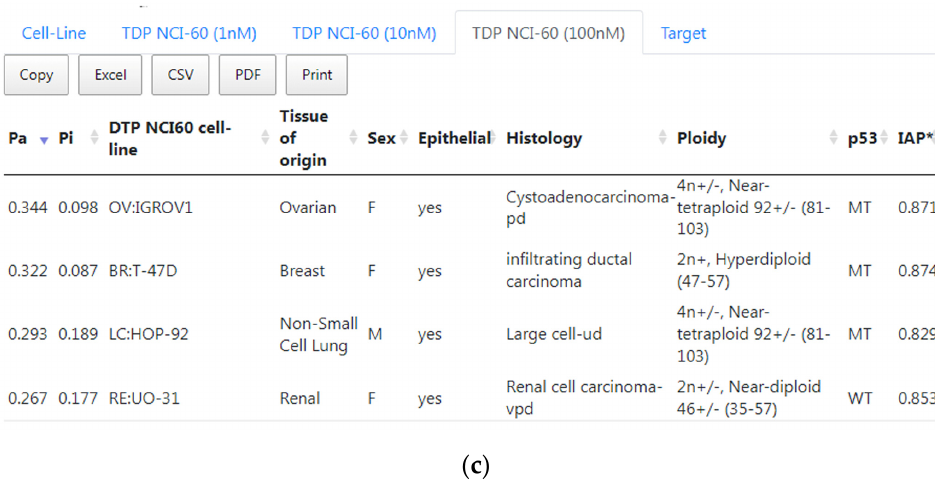
Figure 5. CLC-Pred 2.0 results of cytotoxicity prediction based on the TDP’s NCI60 data for erlotinib at different threshold of cytotoxicity: ( a ) at 1 nM, ( b ) at 10 nM; ( c ) at 100 nM.